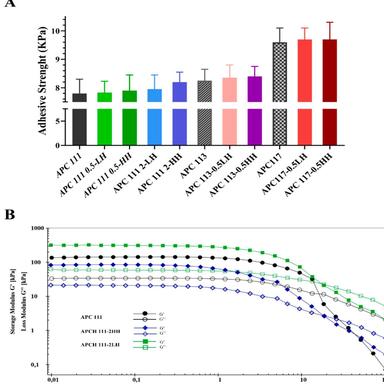
Panel A: Adhesive strength of hydrogels obtained by APCs loaded with different amount and hyaluronate in comparison with the unloaded powders. Panel B: Amplitude sweep test of in situ gelled powders, storage modulus (G′), and loss modulus (G″) of APC 111 (green) in comparison with APCH 111–2HH (blue) and APCH 111–2LH (green). (For interpretation of the references to colour in this figure legend, the reader is referred to the web version of this article.)